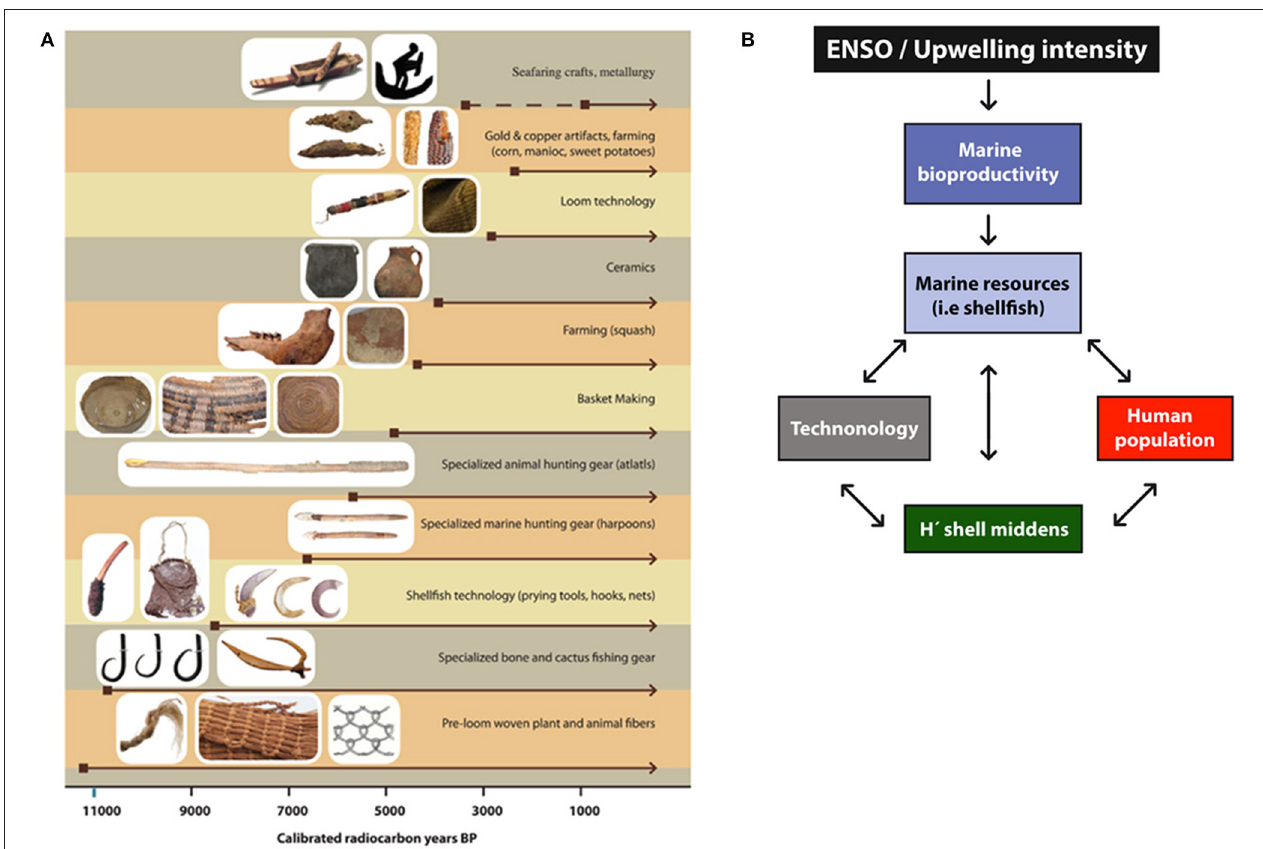
FIGURE 1 | (A) Key technological innovations over the last 11,000 years associated with the extraction of coastal resources in northern Chile. (B) A “cascade effect” diagram showing the relationship between El Niño-Southern Oscillation (ENSO), coastal upwelling and marine bioproductivity and how these impact coastal human ′ populations, technological innovations and resource extraction (measured using a diversity index such as H